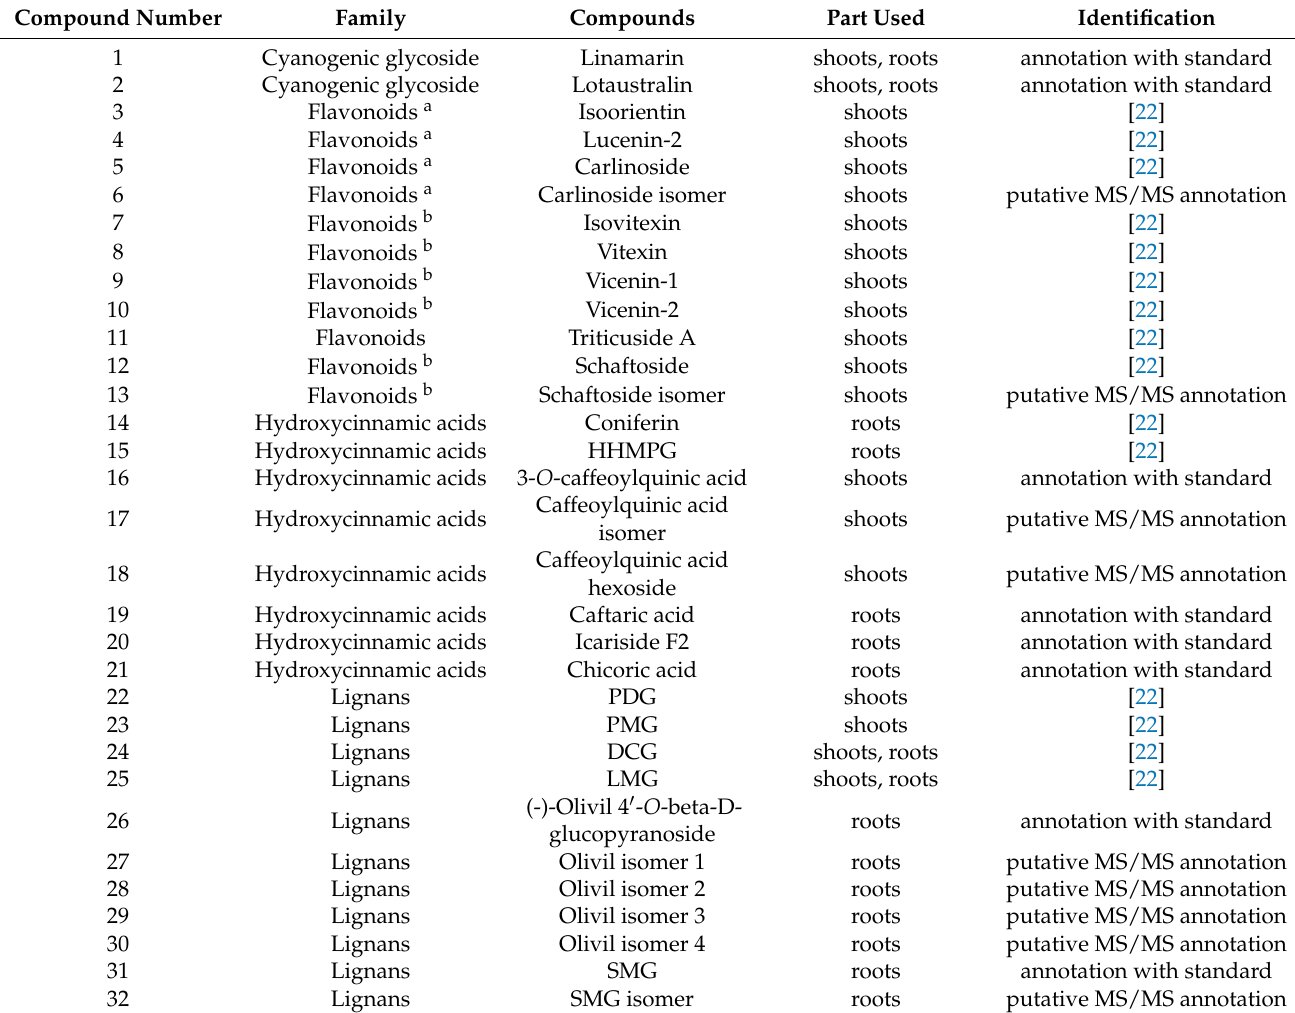
Table 1. Summary of metabolites identified and studied in the roots and shoots of flax